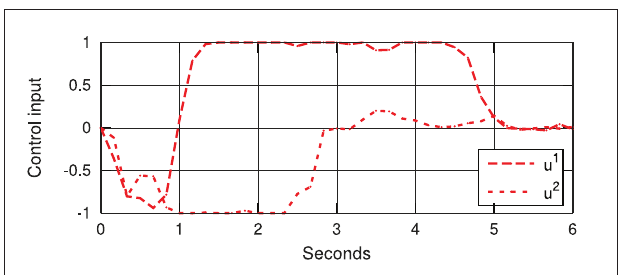
FIGURE 15 | Control input (with normalized units of pixel/s) of the experiment shown in Figure 12b